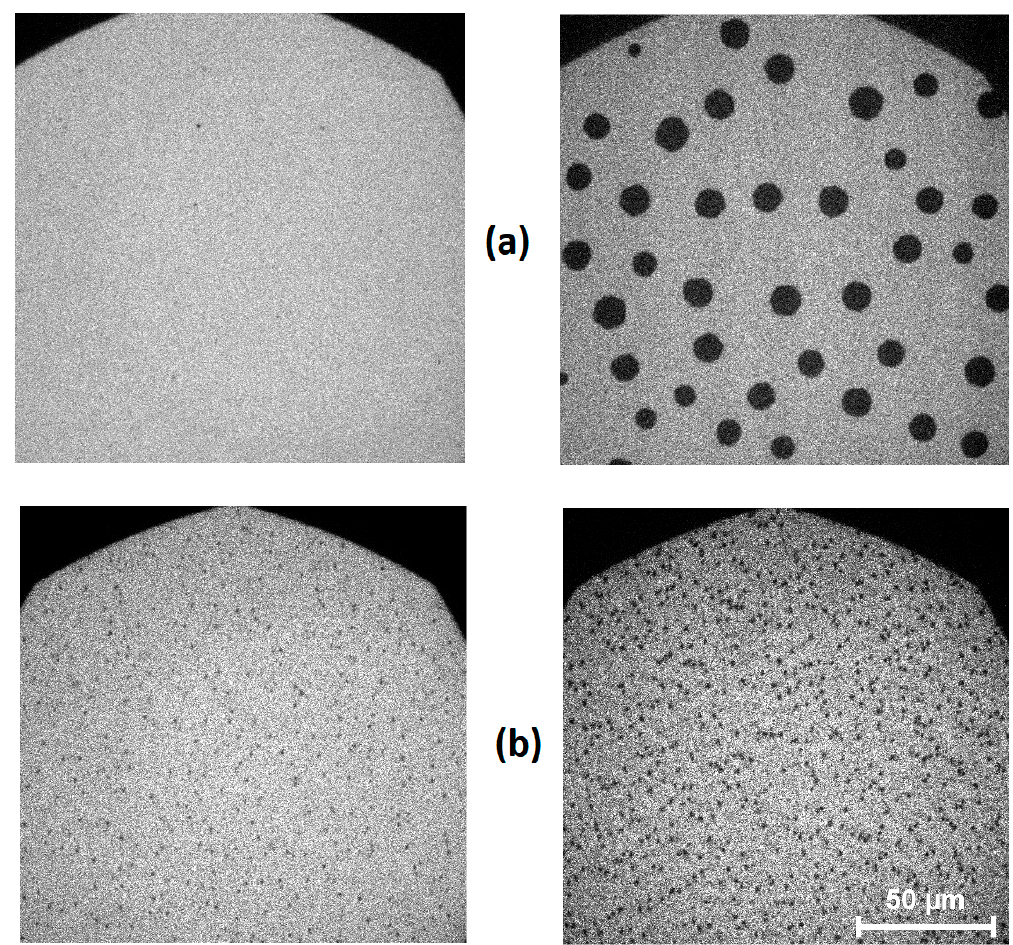
Figure 4. Epifluorescence images of ( a ) Ethoxy-PPE at π of 2 mN / m, A ~ 96 Å 2 (left) and 7 mN / m, A ~ 63 Å 2 (right), and ( b ) Methyl-PPE- co -decadiene at π of 2 mN / m, A ~ 84 Å 2 (left) and 9 mN / m, A ~ 47 Å 2 (right). The images are captured during the film compression at a compression rate of 50 Å 2 / (molecule min). The image size is 164 × 164 µ m 2 .